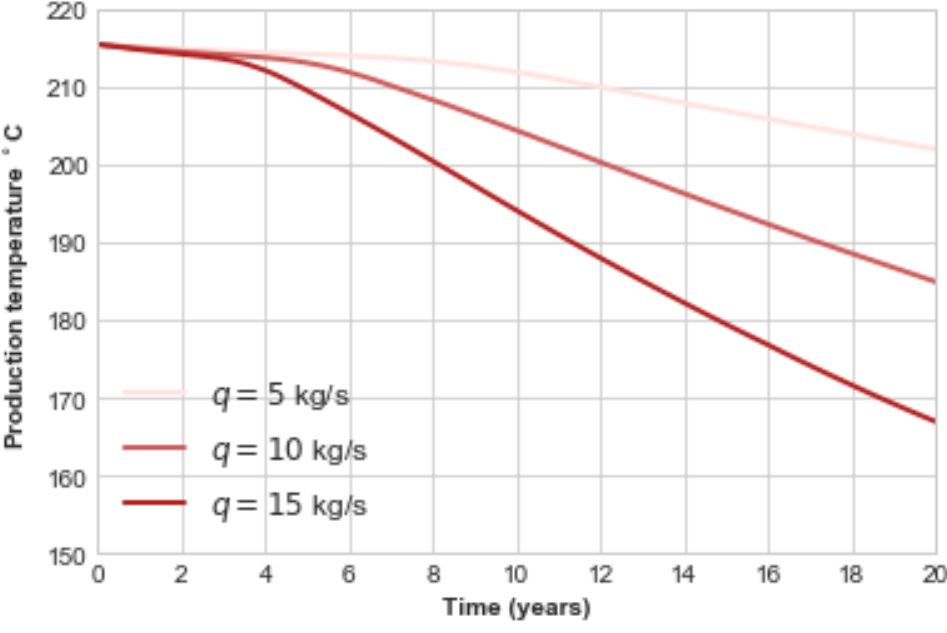
Figure 14. Production temperature decline curve over 20 years of simulation for the scenarios with original permeability [2].